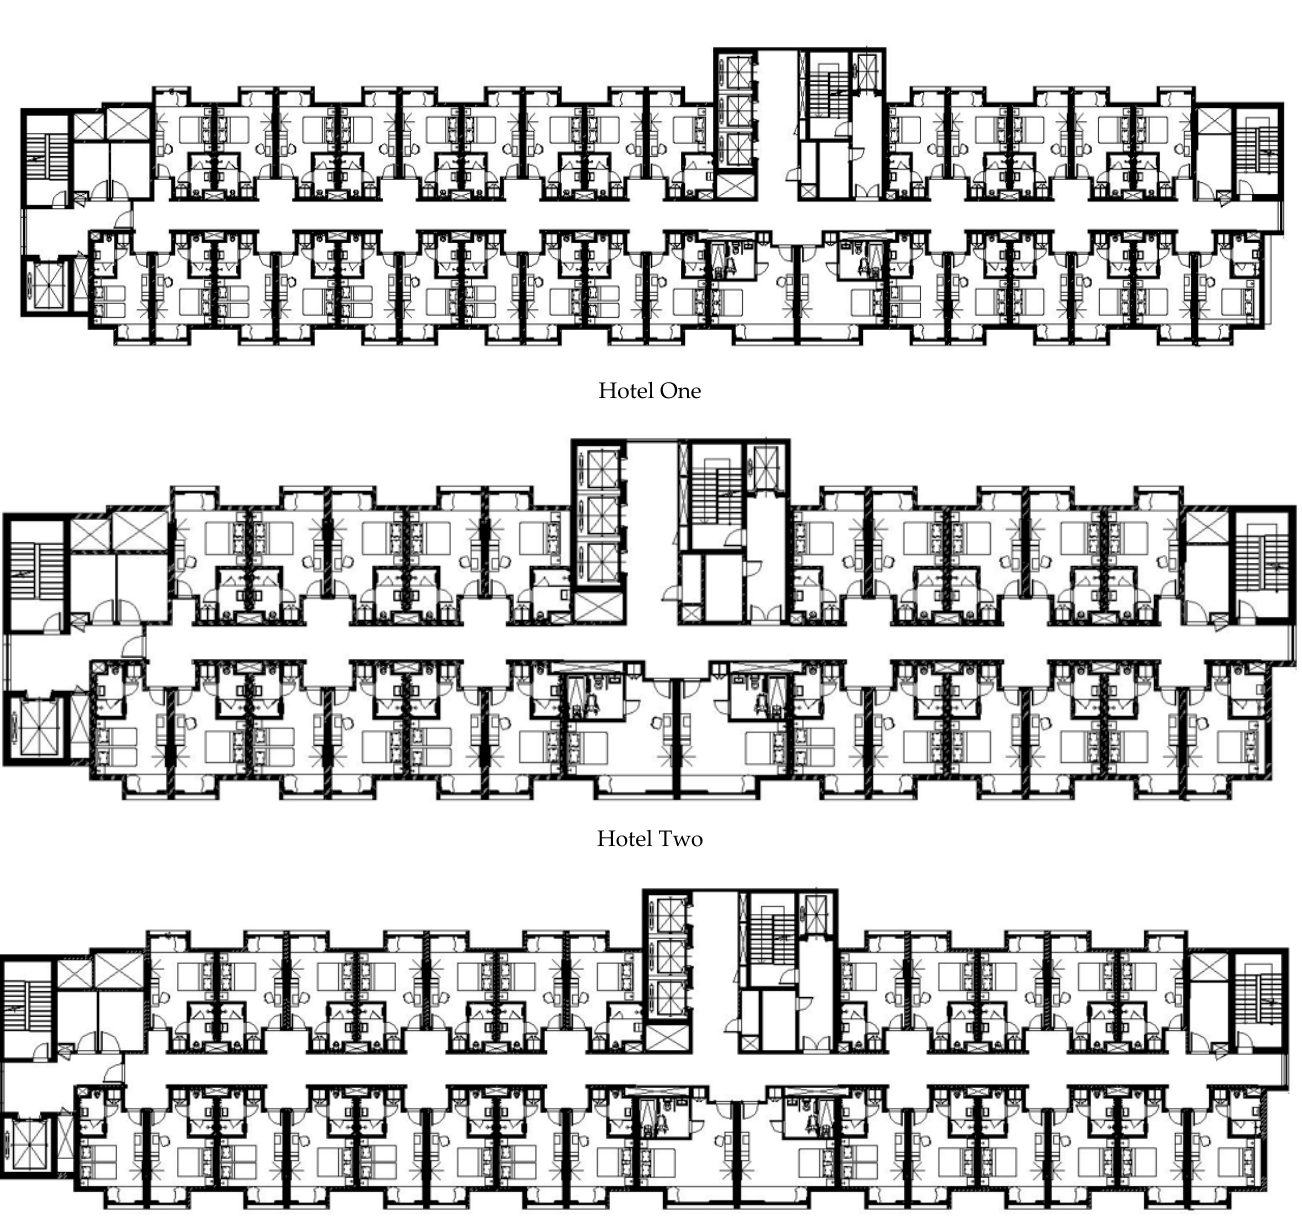
Figure 3. Hotel floor layouts. Table 1. Renovation activity data.